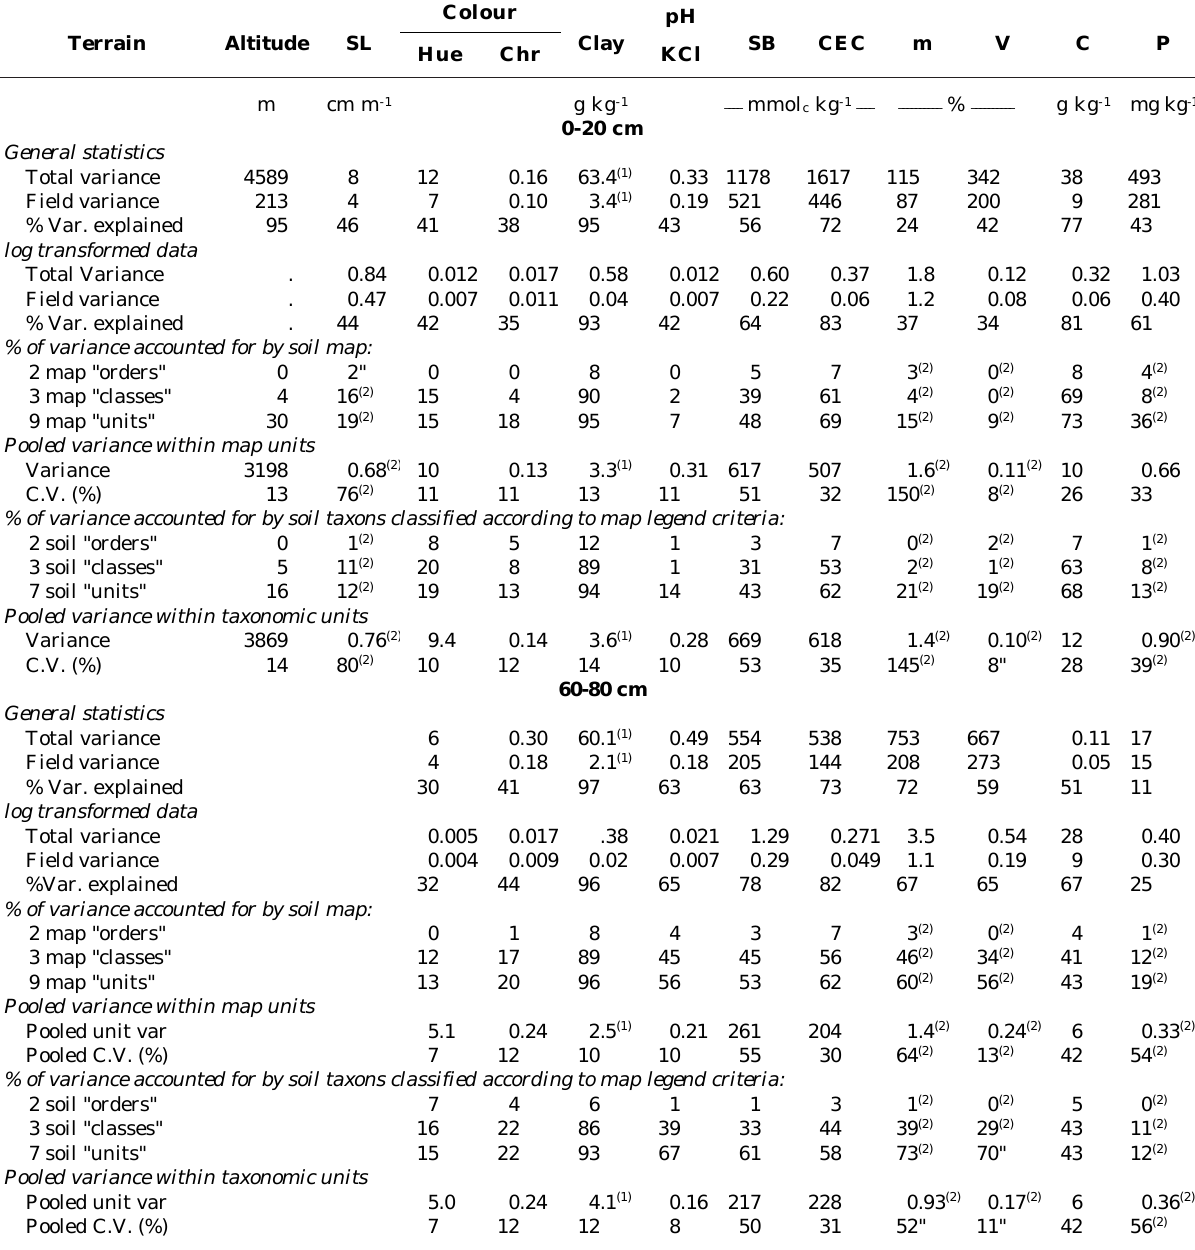
Table 7. Variance by soil map units and soil taxons for 229 sites in the Assis region